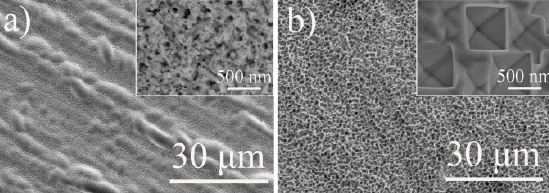
Figure 5. SEM image of the etched sample ( a ) without or ( b ) with NSR treatment at 50 °C for 180 s.